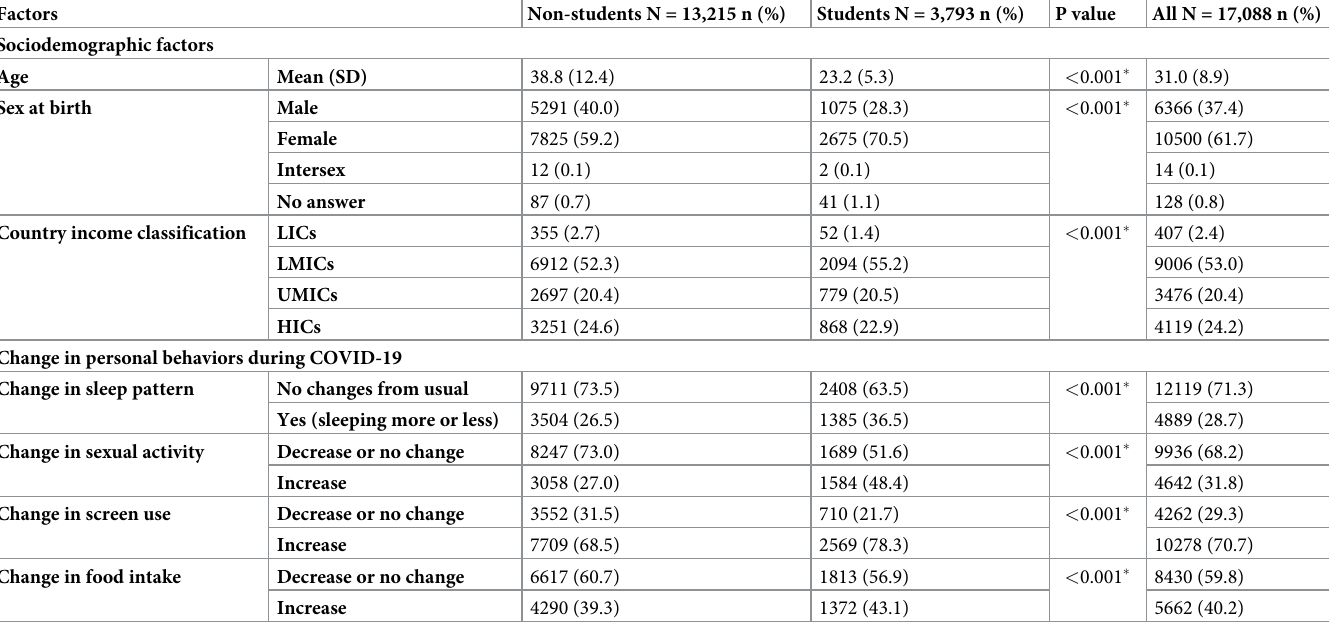
Table 1. Differences between students and non-students by their sociodemographic factors and change in personal behaviors during the pandemic (N = 17,008).